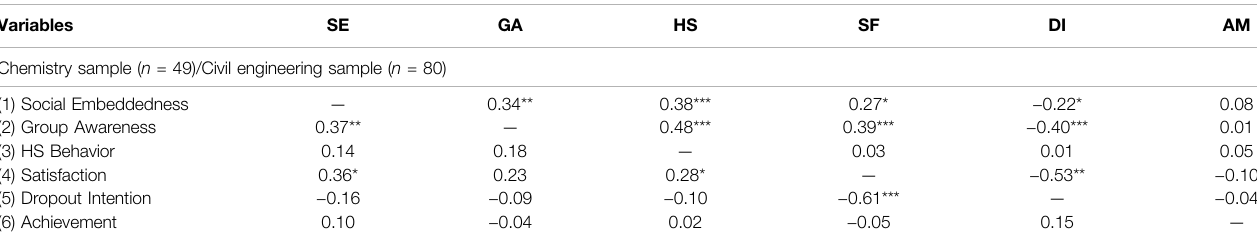
TABLE 3 | Bivariate spearman correlations between constructs. Values below the diagonal are for chemistry sample and above for civil engineering. Variables SE